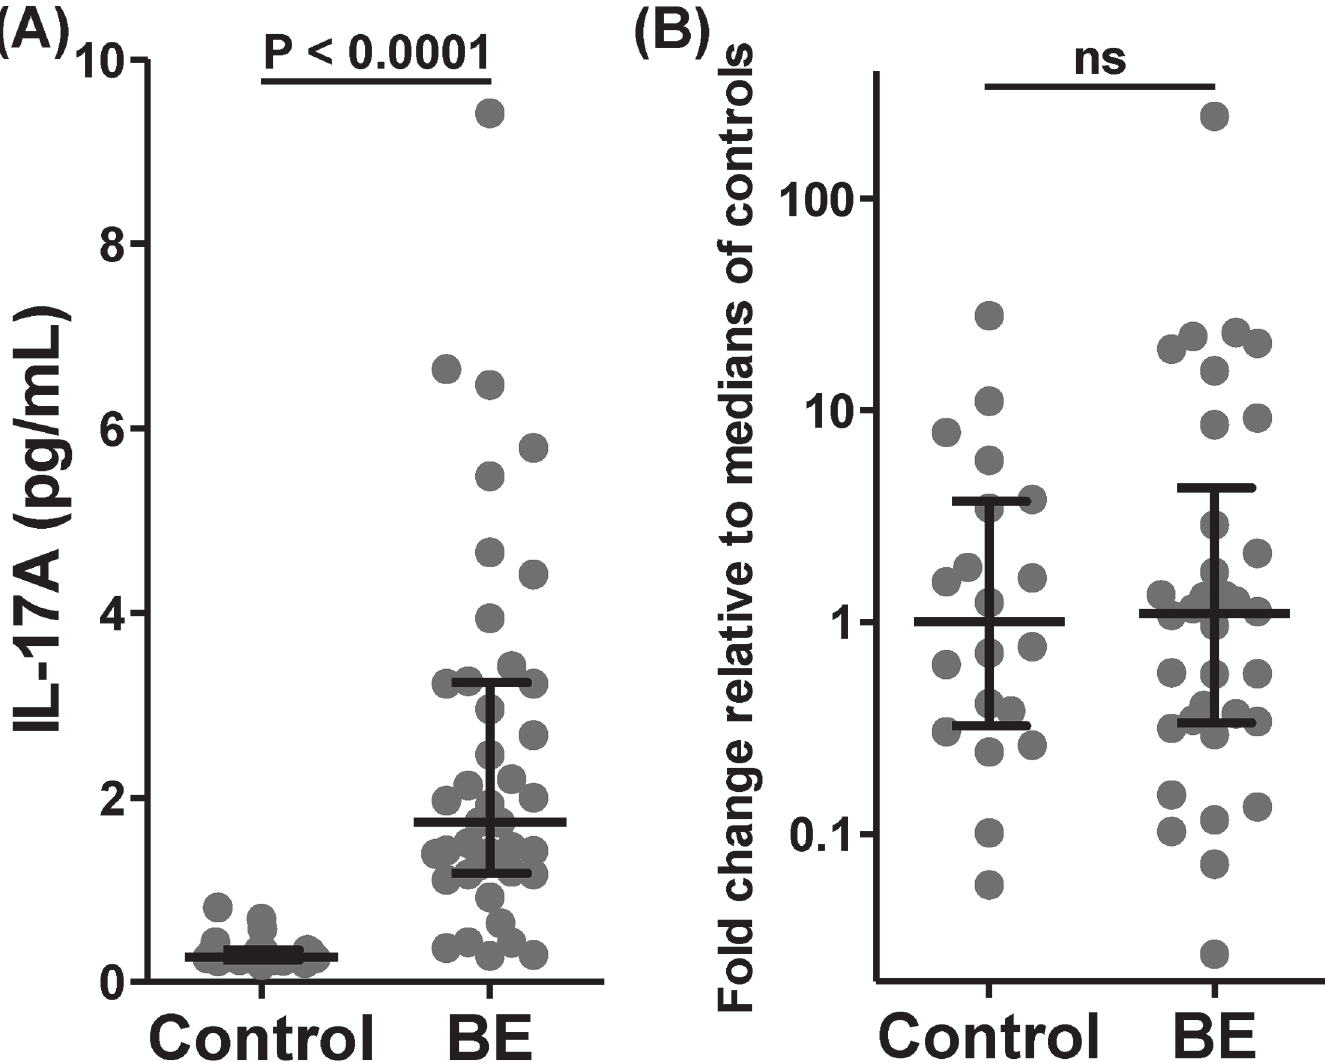
Fig 1. Airway luminal but not mucosal levels of IL-17A are significantly increased in adult non-CF bronchiectasis compared with healthy control subjects. (A) Bronchoalveolar lavage fluid levels of IL-17A comparing bronchiectasis (n = 41) and healthy control (n = 20) subjects; (B) Gene expression of IL-17A in endobronchial biopsies from bronchiectasis (n = 34) and healthy control (n = 20) subjects. (Cont — control, BE — bronchiectasis; Box and whisker plots display median and interquartile ranges; p values are by Mann-Whitney U